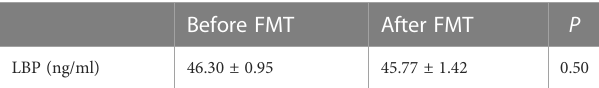
TABLE 2 Changes of LBP before and after fecal bacterial